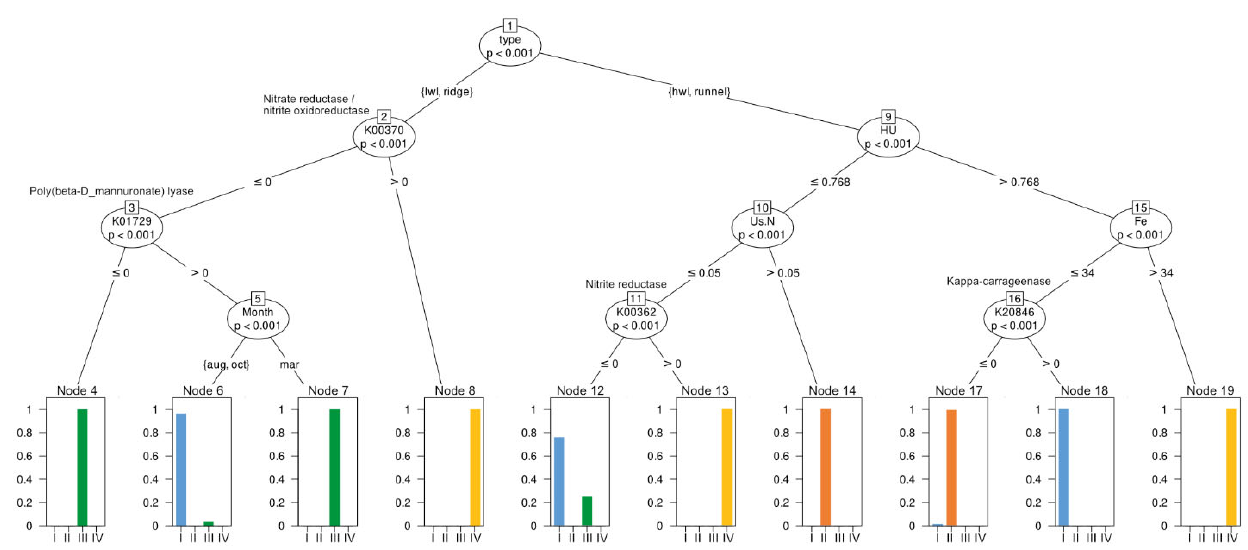
Figure 4. Conditional inference tree. Porewater nutrient data, DOM data and indices, and key genes of catabolic processes were used for a prediction of which environmental factors favor the occurrence of the bacterial clusters detected. Cluster I = blue, Cluster II = orange, Cluster III = green, Cluster IV = yellow.